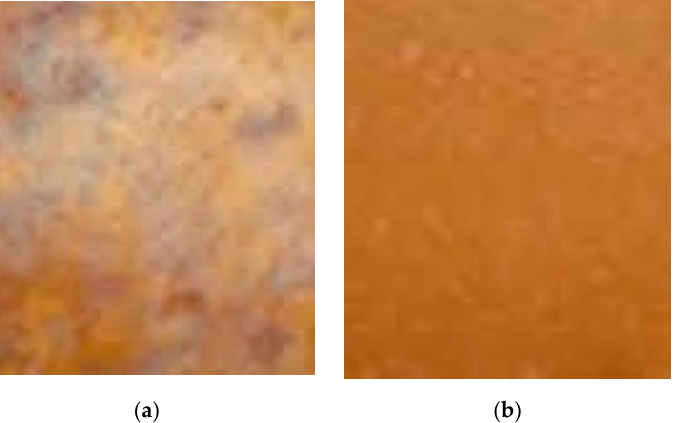
Table 4. The fungus growth on the surface area of the dried sheet product after storage (PR = para rubber, Bb = bamboo, and CS = coconut shell). Figure 10. The fungus growth on the dried rubber sheet product surface after approximately three months of storage: ( a ) acetic acid and referent and ( b ) wood